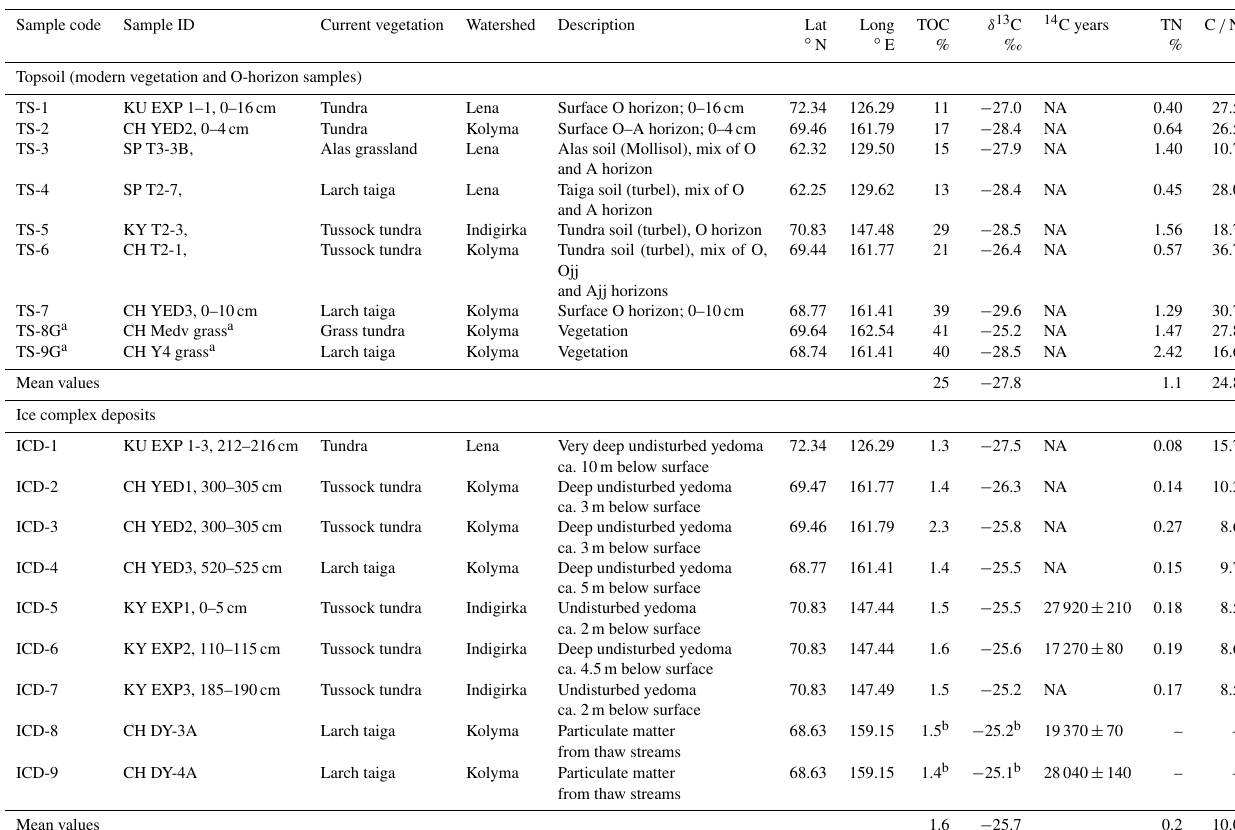
Table 1. Site characteristics and geochemical properties of eight topsoil and eight ice complex deposit samples. A table with more detailed sample descriptions can be found in Table